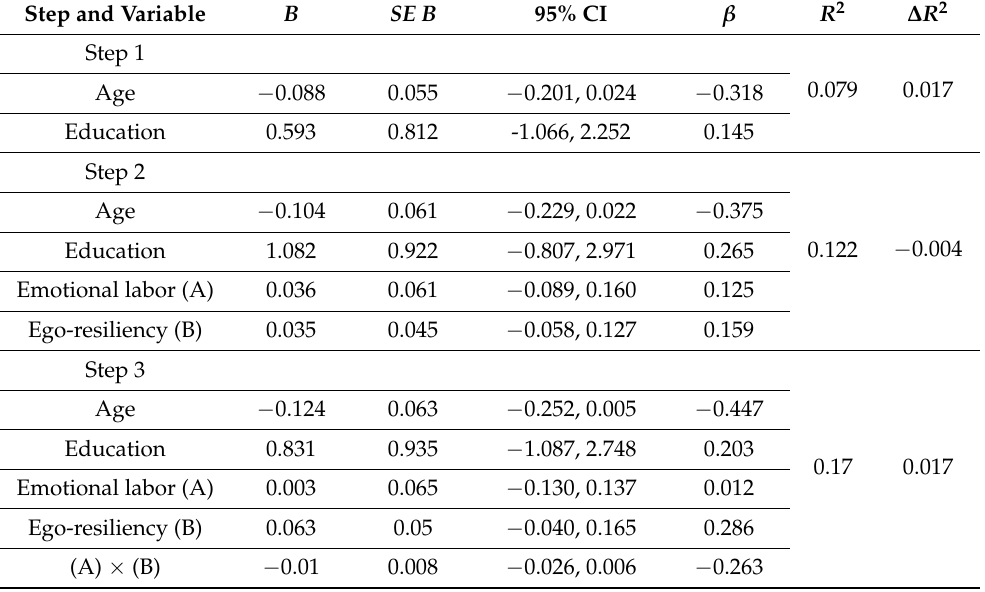
Table 5. Results of hierarchical regression analysis predicting salivary cortisol level from emotional labor with ego-resiliency as the moderator variable in the administrative work